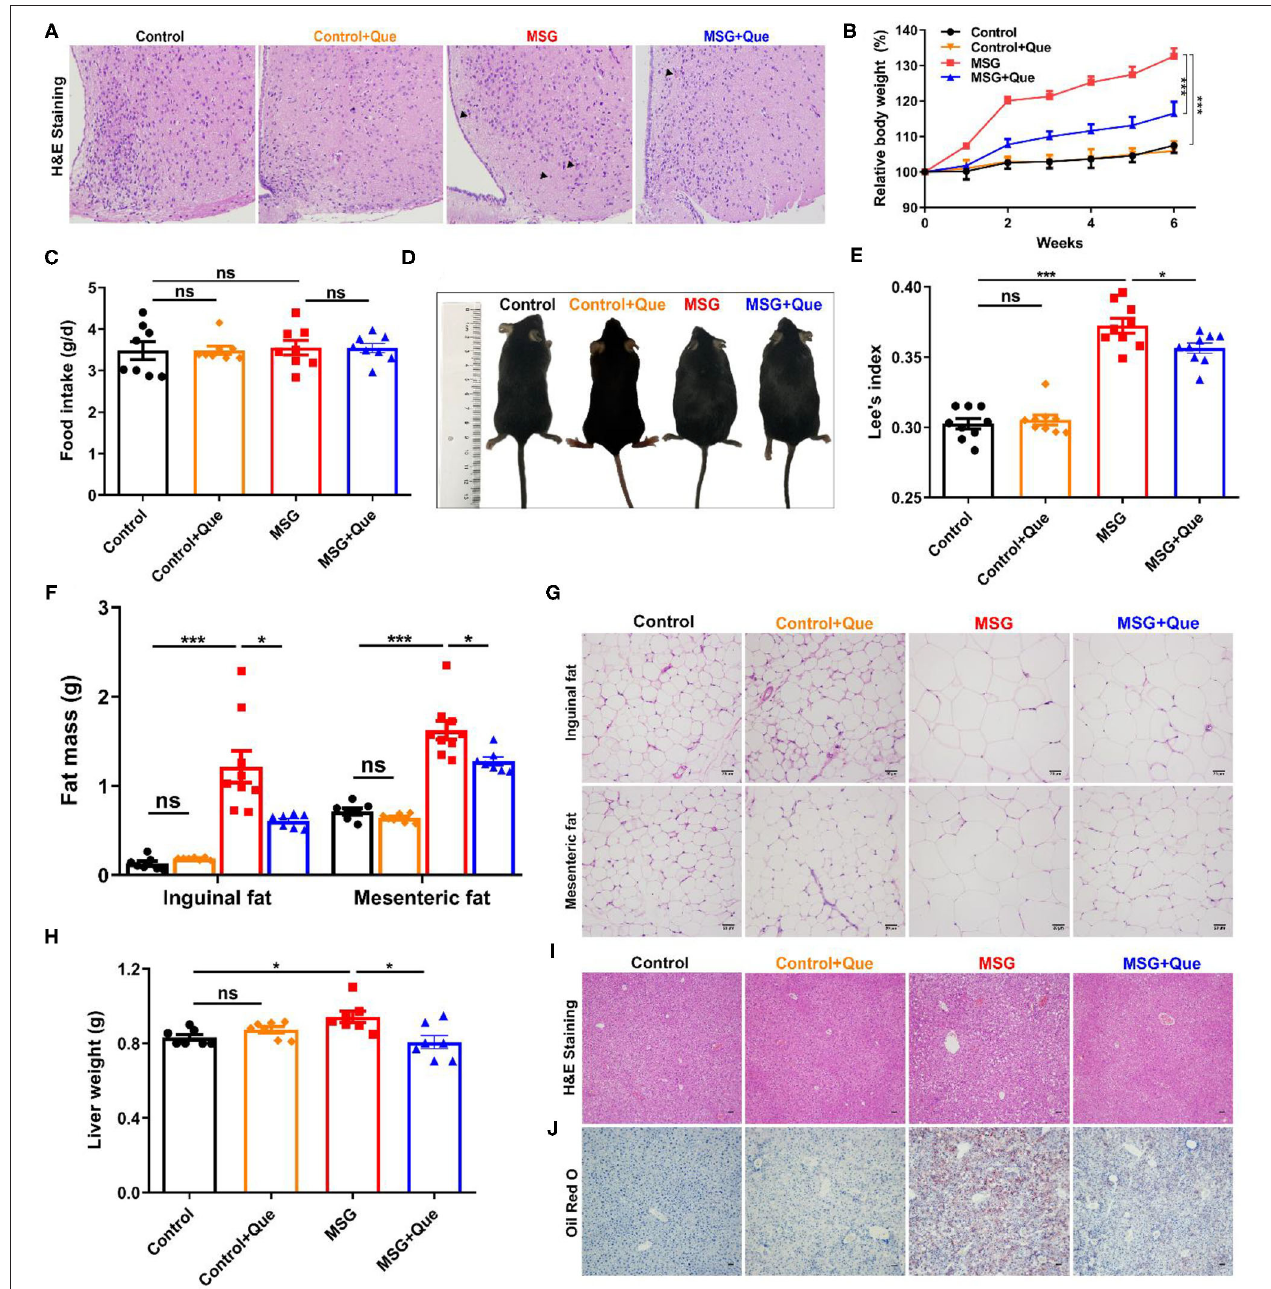
FIGURE 4 | Quercetin treatment alleviates MSG-induced hypothalamic damage and abdominal obesity. (A) H&E staining in the arcuate nucleus of hypothalamus. (B) Relative body weight. (C) Food intake per day. (D) Mice morphology. (E) Lee’s index. (F) Fat mass and (G) H&E staining of inguinal and mesenteric adipose tissues. Scale bar: 20 µ m. (H) Liver weight. (I) H&E staining and (J) Oil Red O staining of liver tissues. Scale bar: 20 µ m. Data are presented as mean ± SEM, n = 5–10. Data were analyzed by two-way ANOVA followed by post-hoc LSD tests. * p < 0.05, *** p < 0.001, ns, no significance. Arrowheads indicate eosinophilic